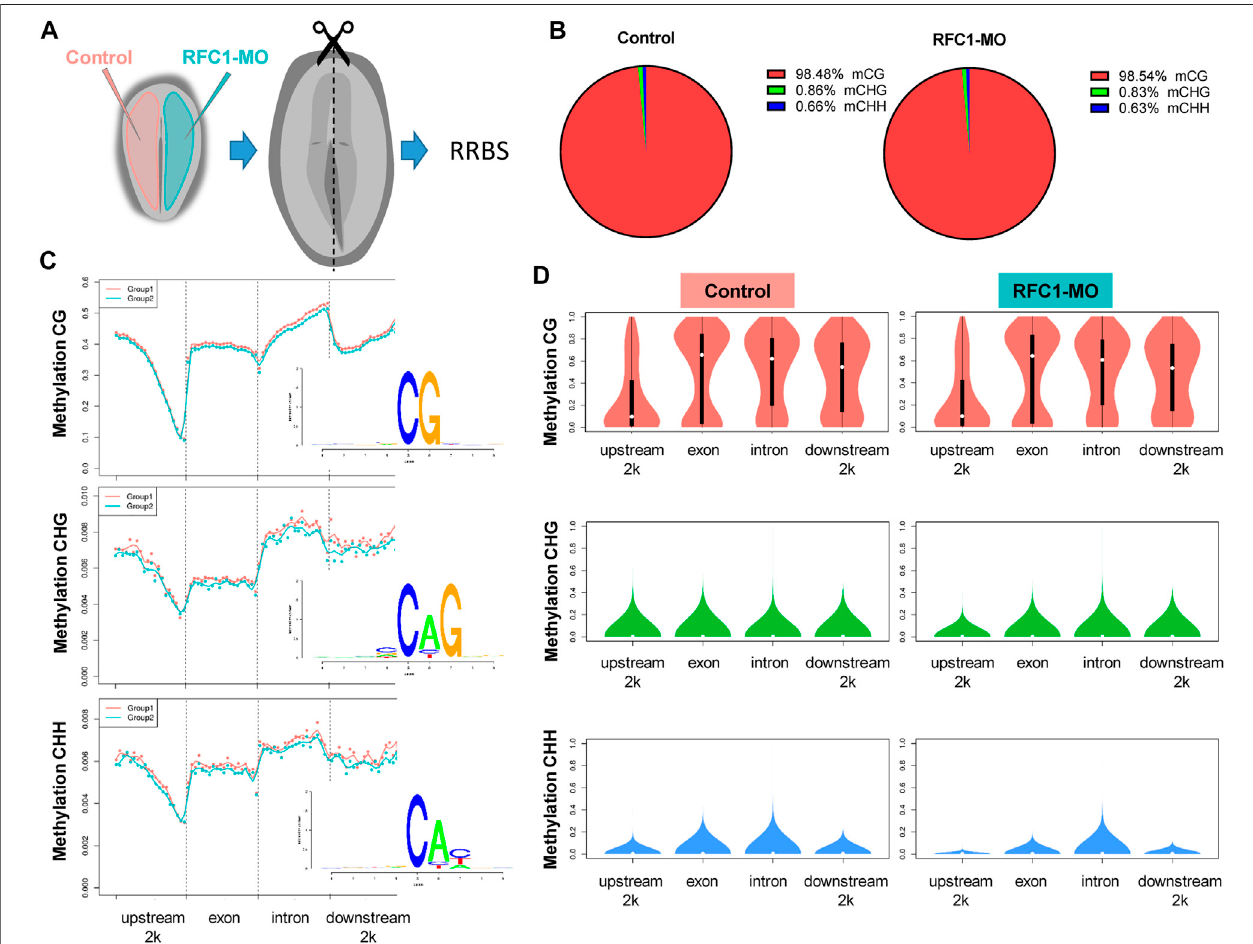
FIGURE 3 | Global analysis of cytosine methylation by reduced representation bisulfate sequencing (RRBS) on folate carrier de fi cient embryos. (A) Schematic representation of loss-of-function experiments performed to generate a folate carrier de fi cient model. Embryos were bilaterally electroporated with Rfc1 (RFC1-MO) or control (Control) morfolinos, grown until HH7 and genomic DNA was isolated from each side for RRBS sequencing. (B) Pie chart analysis of overall cytosine methylation at the three genomic contexts (CG, CHG, and CHH) in control and RFC1-MO treated embryos. (C) Comparative analysis of methylation levels in distinct genomic functional elements displayed for CG, CHG, and CHH in control and RFC1-MO treated embryos. Motif occurrence for CG, CHG, and CHH context are shown on the insets for each graph. (D) Averages for methylation levels in functional regions for CG, CHG, and CHH in control and RFC1-MO treated embryos. Nonsigni fi cant differenceswerefoundinalltheglobalmethylationanalysis (B,C,D) betweentreatments.upstream2k:2 Kbupstreamofthetranscriptionstartsite;downstream2k:2 Kb downstream of the transcription end site.